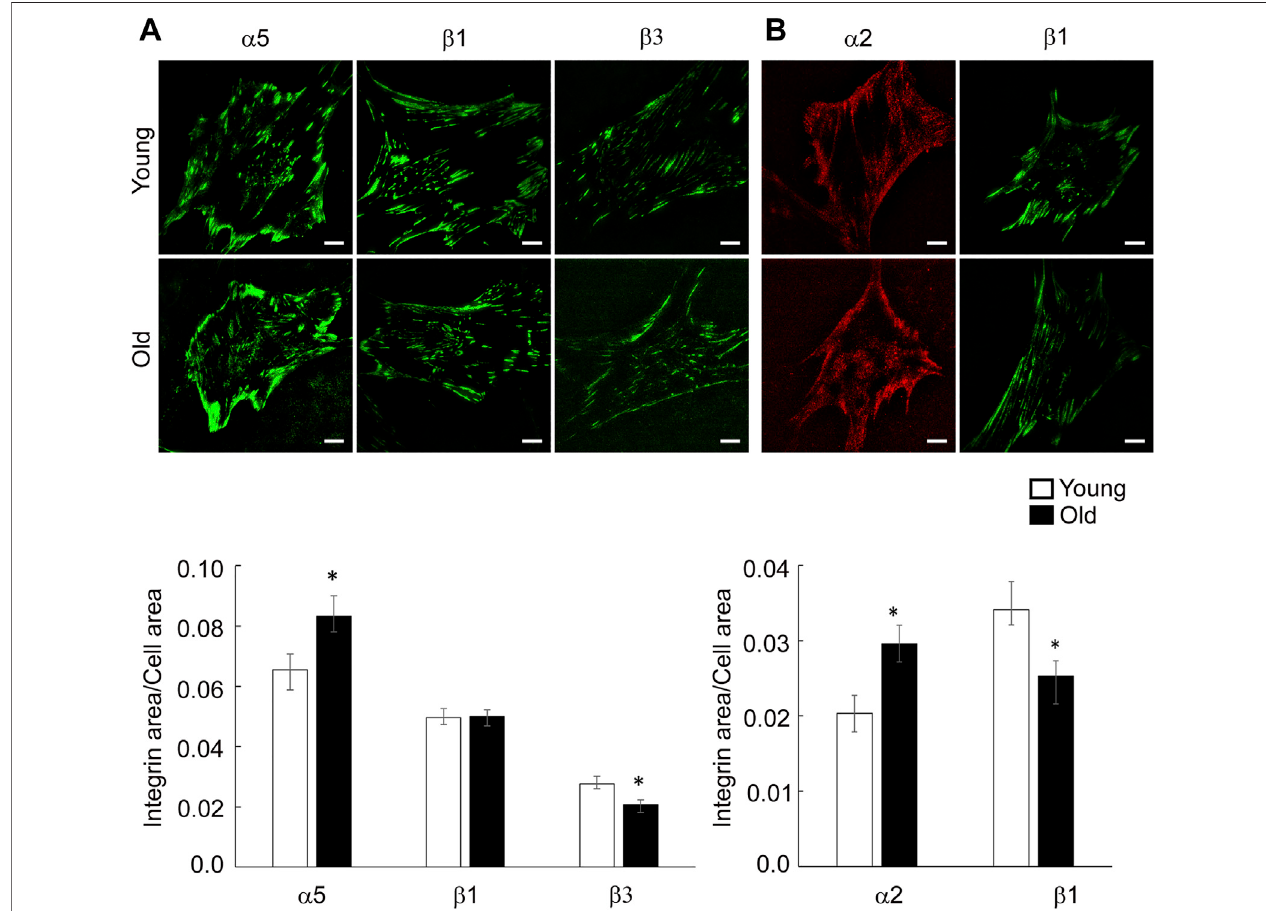
FIGURE 4 | (A) Representative TIRF images of VSM cells plated on fi bronectin and fl uorescently labeled for integrin α 5, β 1 and β 3 are shown. (B) Representative TIRF images of VSM cells plated on collagen-I and fl uorescently labeled for integrin α 2 (red) and β 1 (green) are shown. Scale bar represents 10 μ m. Quantitative measurements ( n = 15 – 50) are presented as mean ± SE. Signi fi cance was evaluated at p < 0.05.